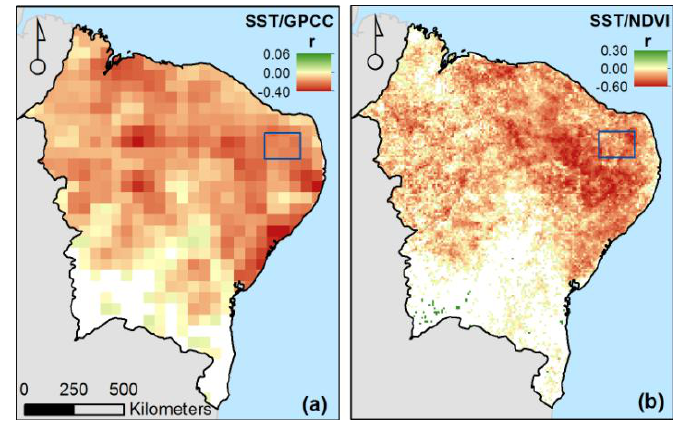
Figure 8. Coefficient of variation (r) for linear regression for the period of 1982–2010 between monthly Nino 3.4 SST anomalies and ( a ) GPCC precipitation data (lag = 9) and ( b ) NDVI3g data (lag = 12); (white = no significance, p <